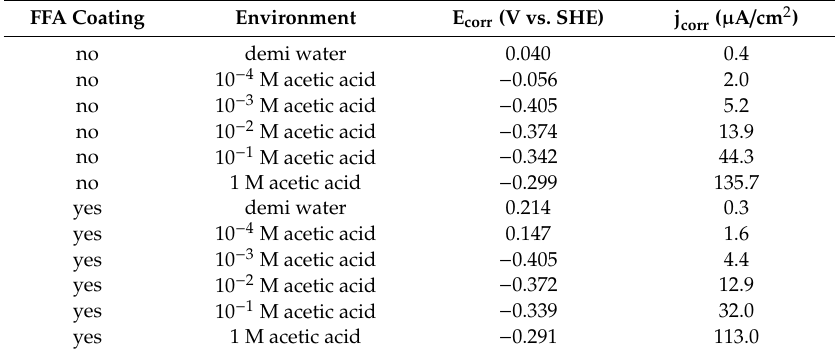
. Temperature = 90 ◦ C. corr